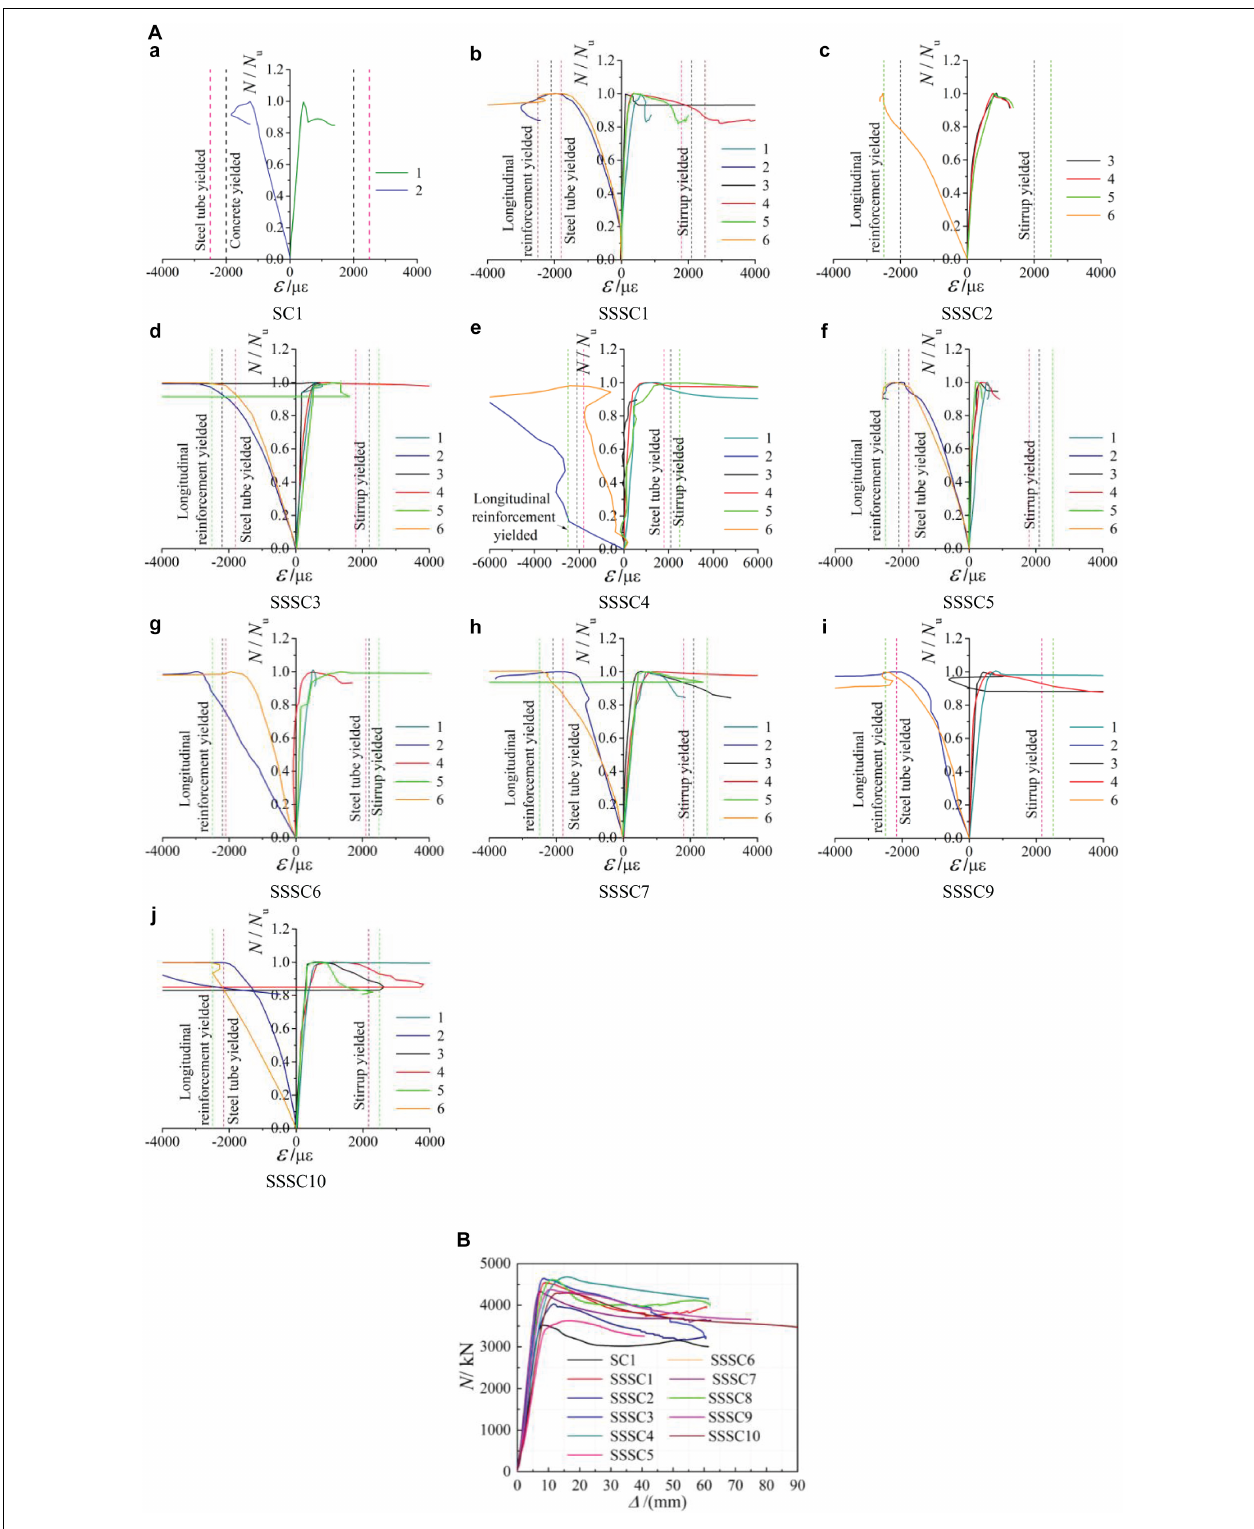
FIGURE 4 | Load-strain curves and load-displacement curves. (A) Load-strain curves. (a) SC1, (b) SSSC1, (c) SSSC2, (d) SSSC3, (e) SSSC4, (f) SSSC5, (g) SSSC6, (h) SSSC7, (i) SSSC9, (j) SSSC10. (B) Load-displacement curves.